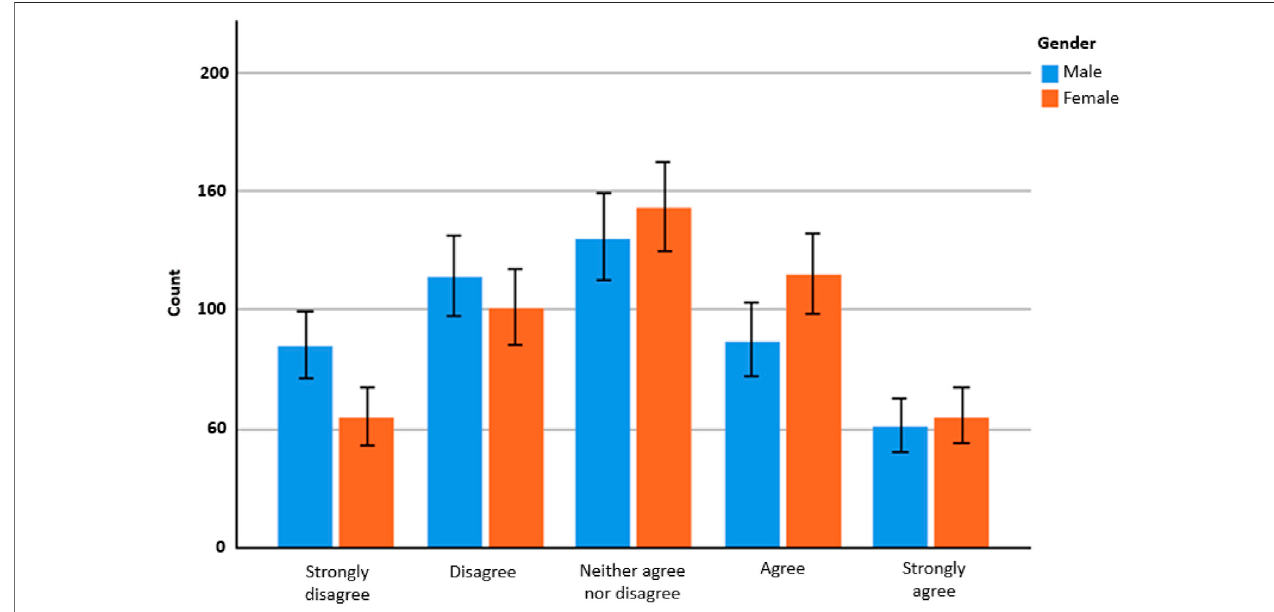
FIGURE 4 | Differences in survey counts for ‘ There is a risk that smart systems are intrusive ’ . Source, authors. Error bars indicate 95% con fi dence interval.